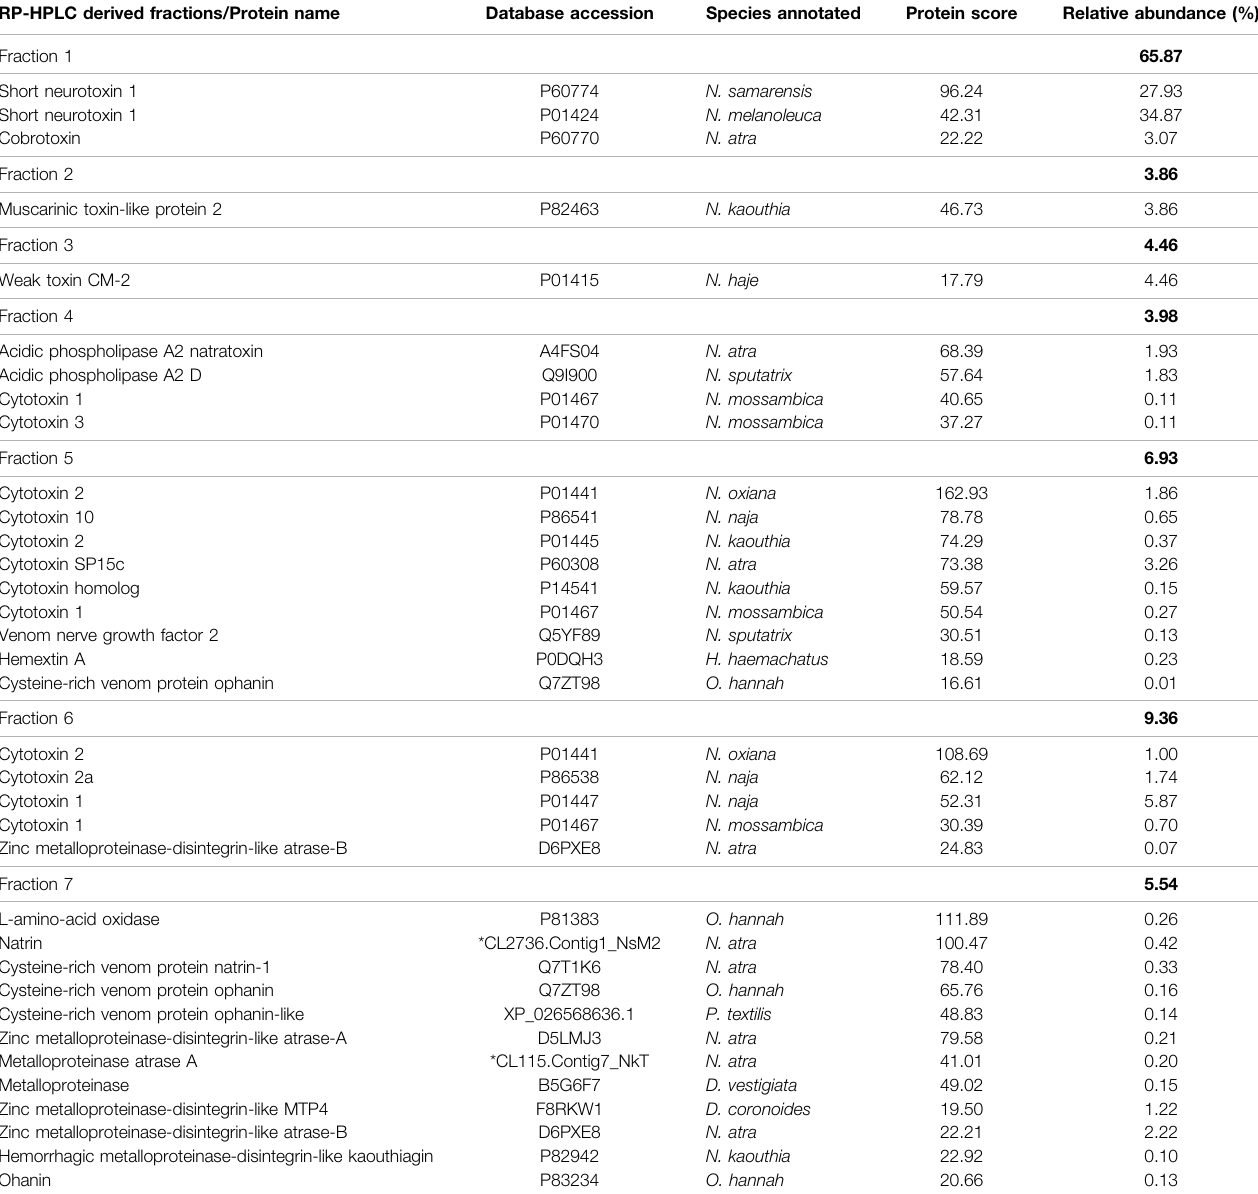
TABLE 1 | Protein identi fi cation from Naja samarensis venom fractions isolated by reverse-phase high-performance liquid chromatography using nano-ESI-LCMS/MS. RP-HPLC derived fractions/Protein